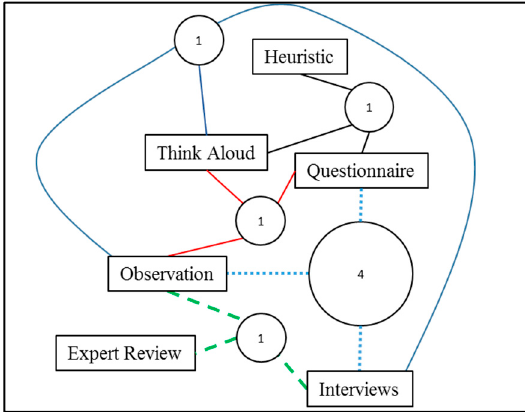
Figure 9. Works with a three technique combination.